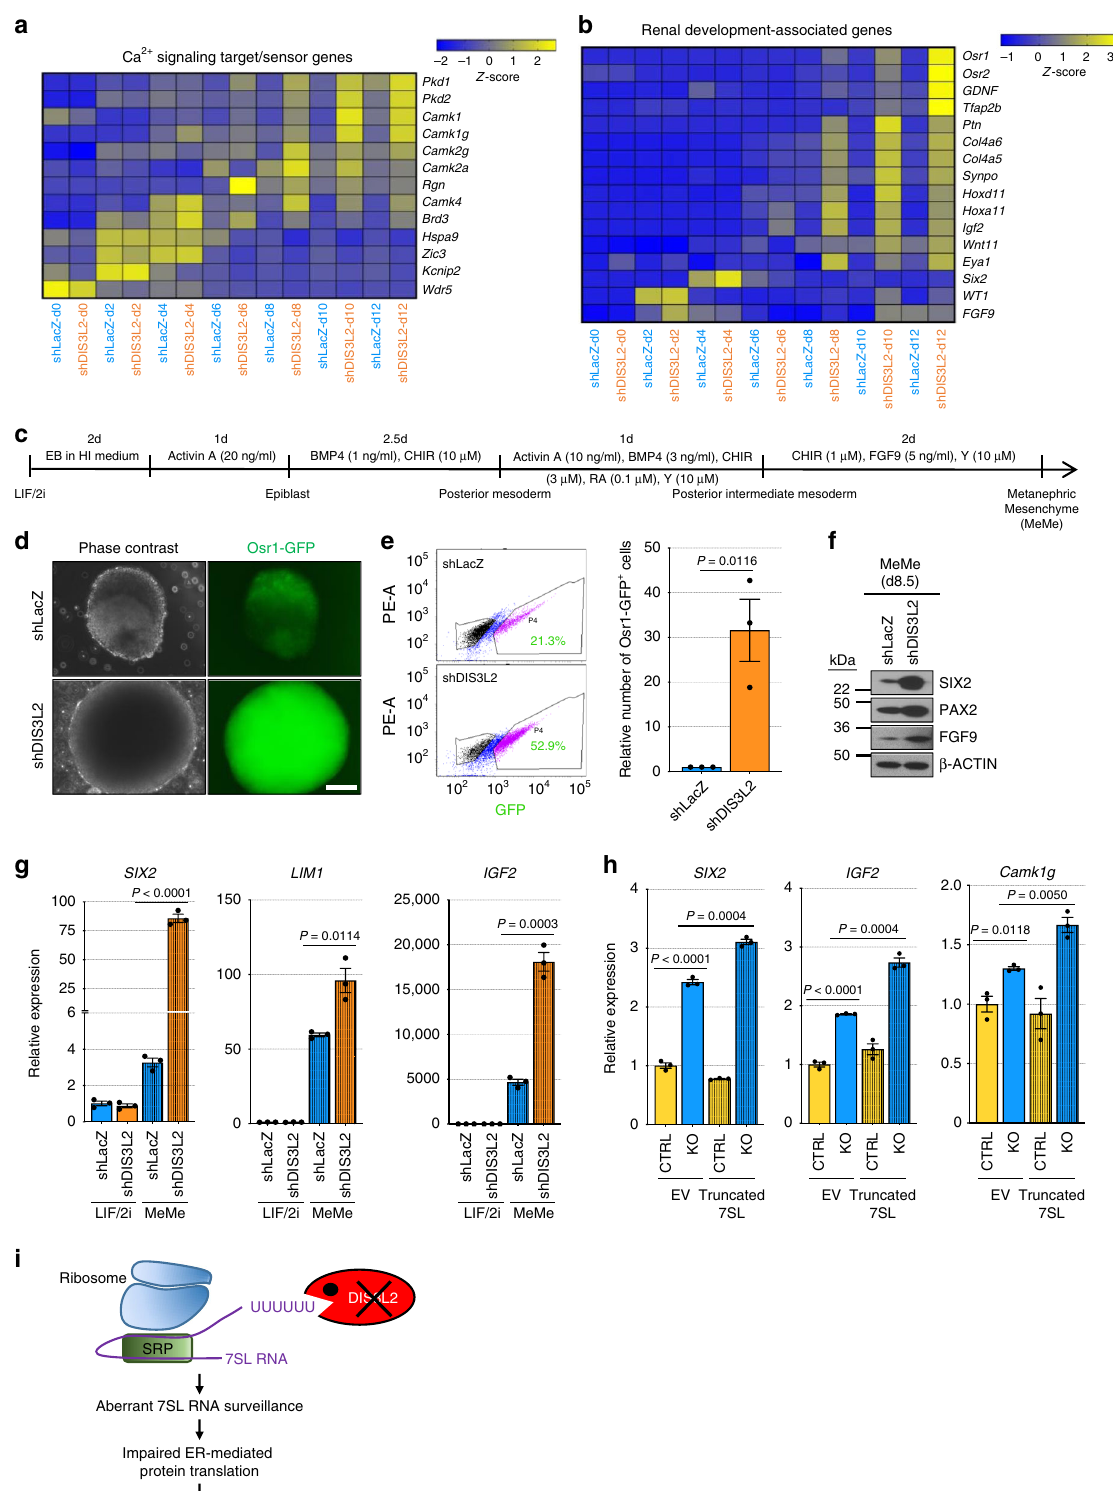
differentiationUUUUUU SRP 7SL Impaired ER Ca 2+ homeostasis; impaired stem cell